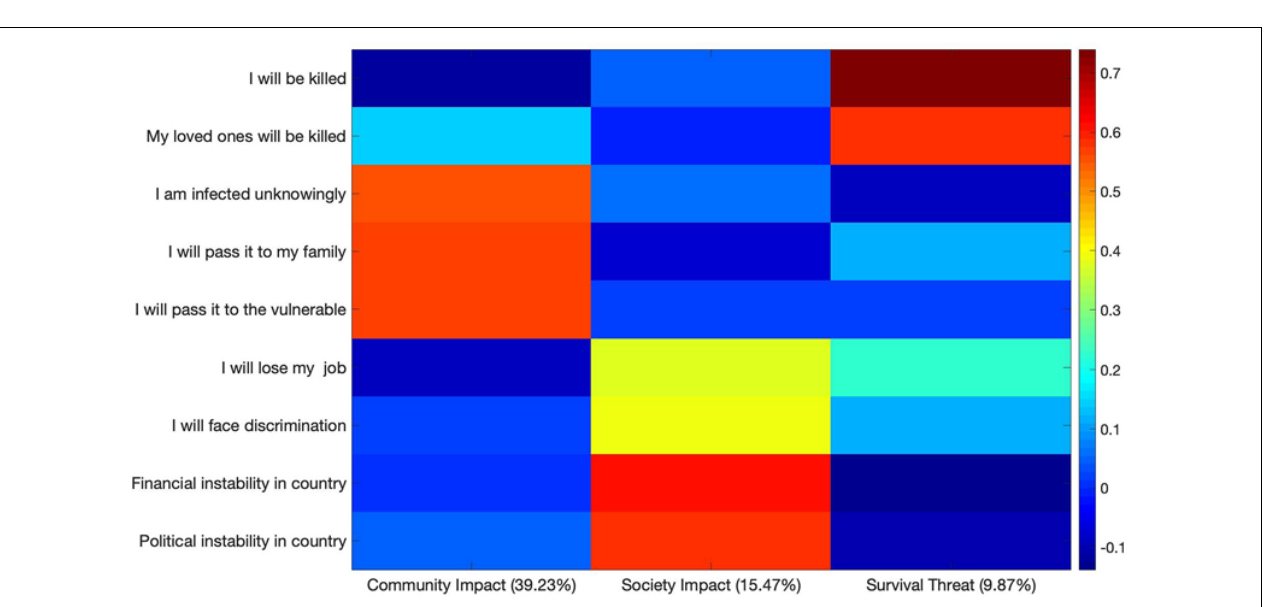
FIGURE 5 | Varimax-rotated PCA solution for the COVID-Specific Worries. Three components account for a collective 64.57% of the